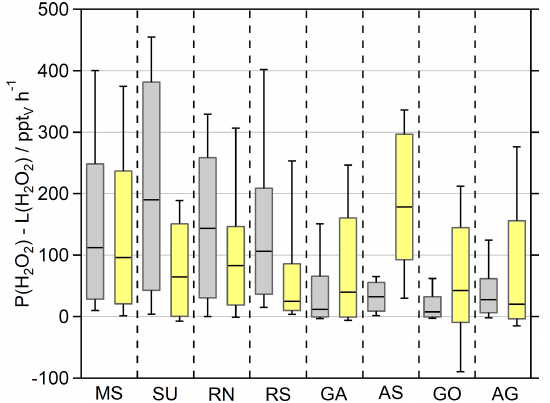
Figure 7. Box plot of the net photochemical production of H 2 O 2 ( P (H 2 O 2 )– L (H 2 O 2 )) of the observations and the EMAC model re- ≥ 10 − 3 s − 1 ). The box repre- sults (yellow) during the day ( j NO 2 sents 25% to 75% of the data, and the whiskers are from 10% to 90% with the median as the black line. The corresponding time- lines are presented in Fig. S11. Note that the deposition term from Eq. (4) is not included in this